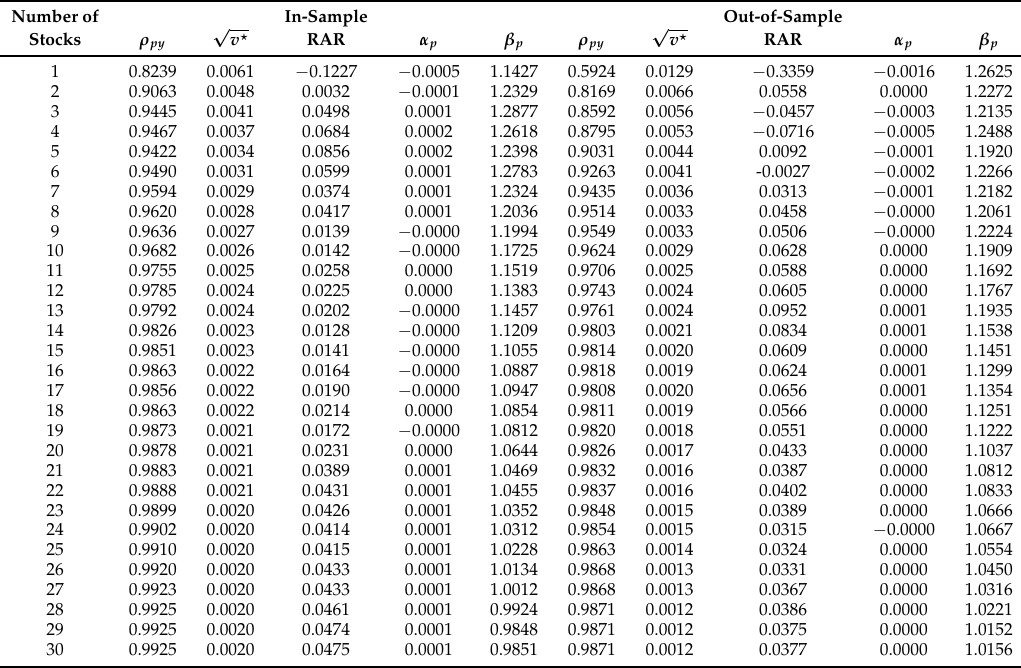
Table 2. Optimal tracking portfolios for DJIA index: Algorithm